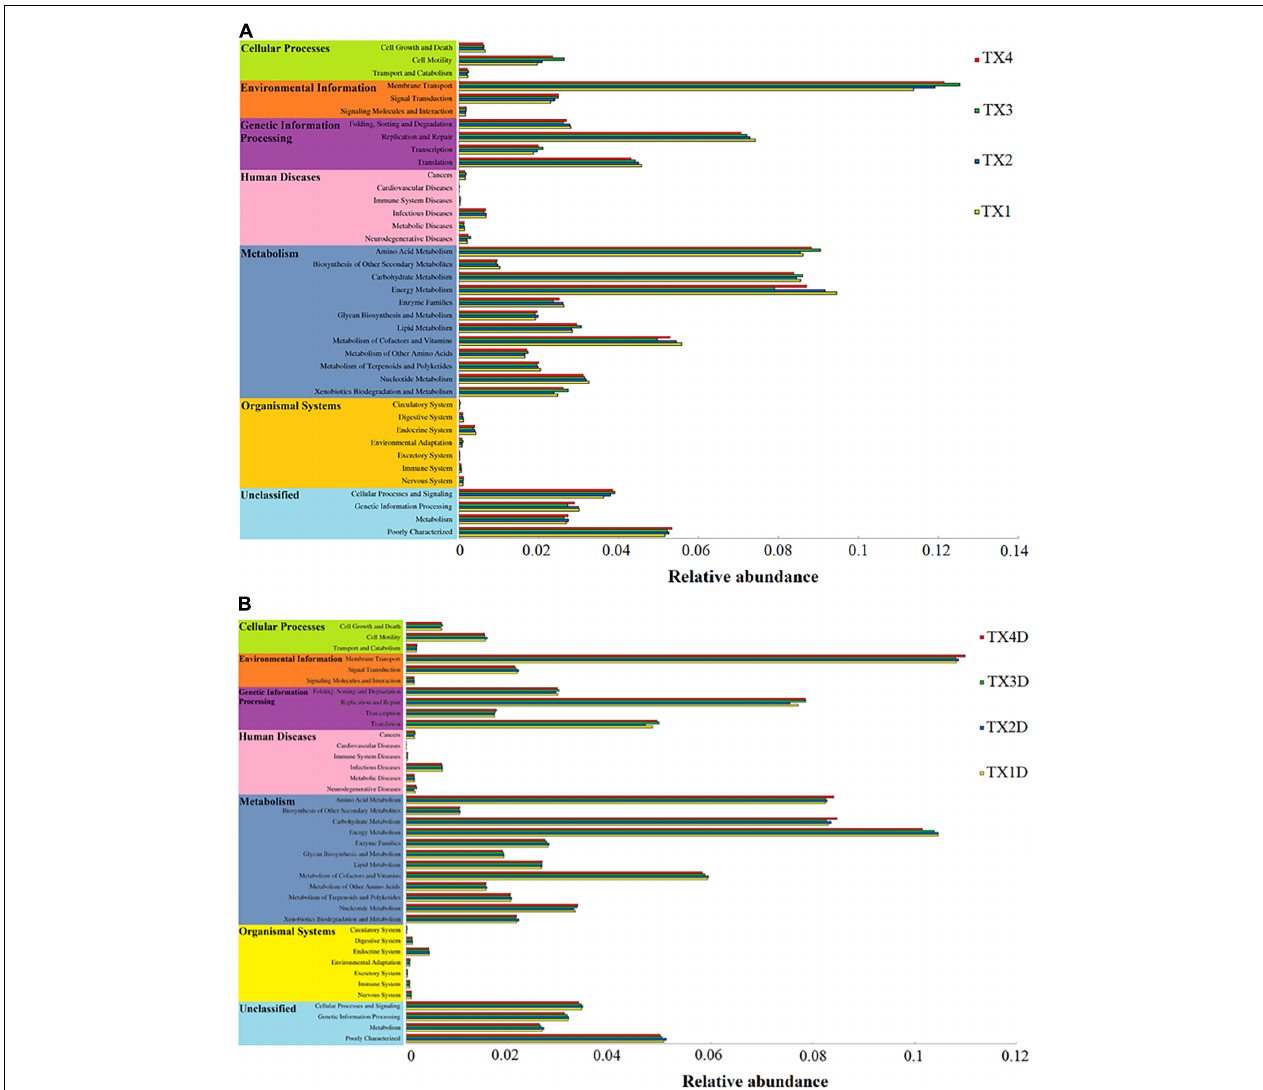
FIGURE 8 | Variation of bacterial function categories in diseased (A) and healthy (B) groups at different disease severity analyzed by